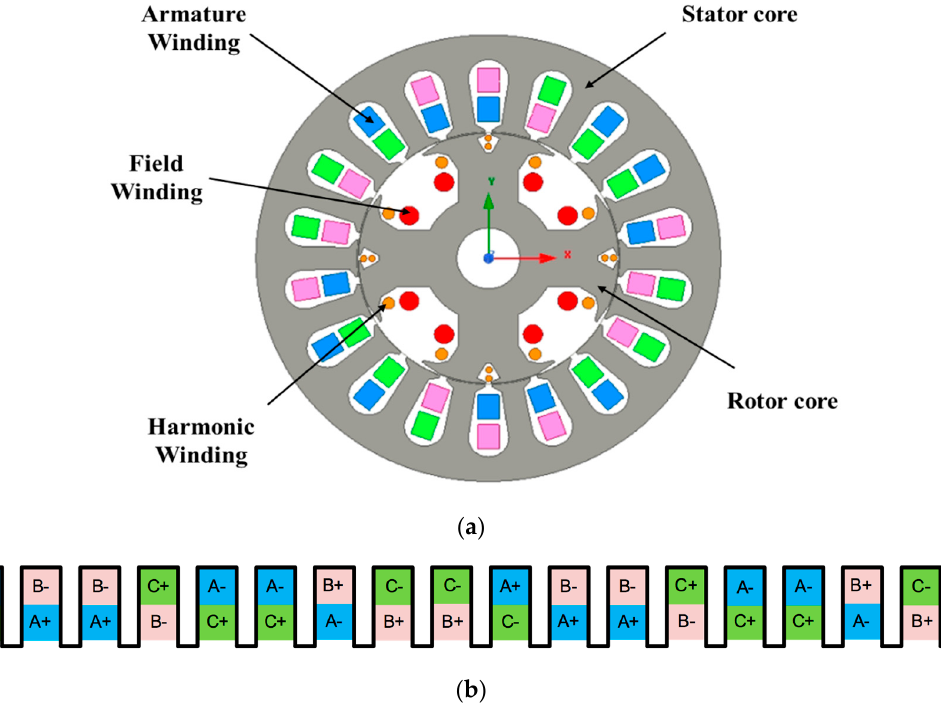
Figure 2. ( a ) Machine structure; ( b ) winding configurations.